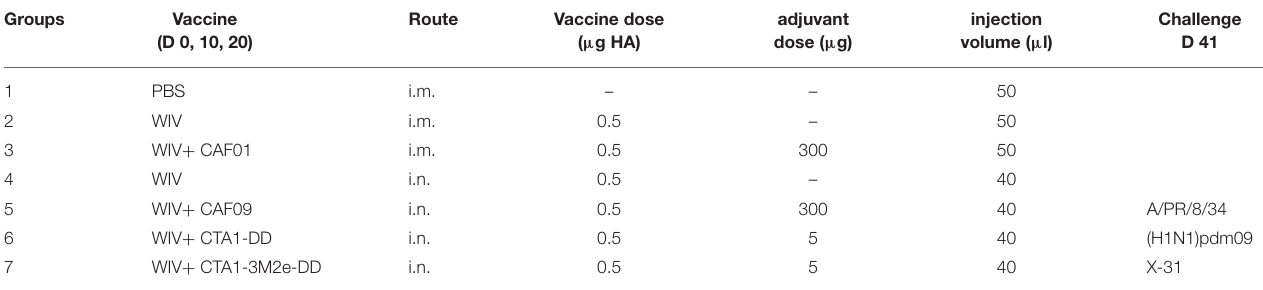
TABLE 1 | Vaccination and challenge scheme.